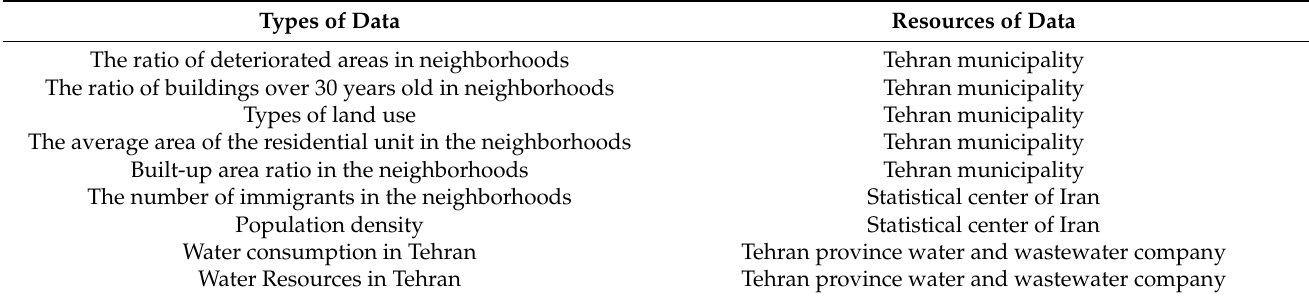
Table 4. Sources of data used in the